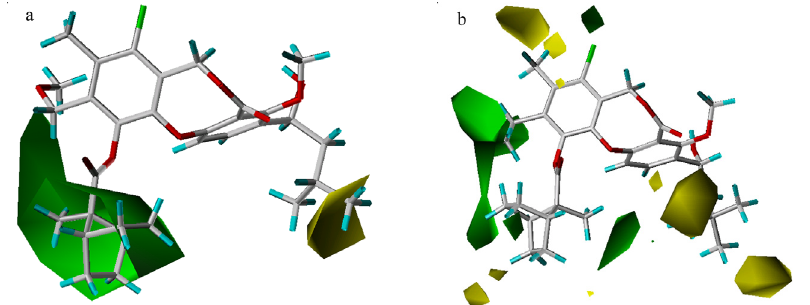
Figure 5. Steric maps from the CoMSIA (a) and CoMFA (b) models. Compound 51 is shown inside the CoMSIA field, while compound 55 is shown inside the CoMFA field. G reen contours (contour level: CoMFA: 0.03; CoMSIA: 0.02) encompass regions that favor bulky groups, while yellow contours (contour level: CoMFA: –0.01; CoMSIA: –0.001) highlight areas that disfavor bulky groups.